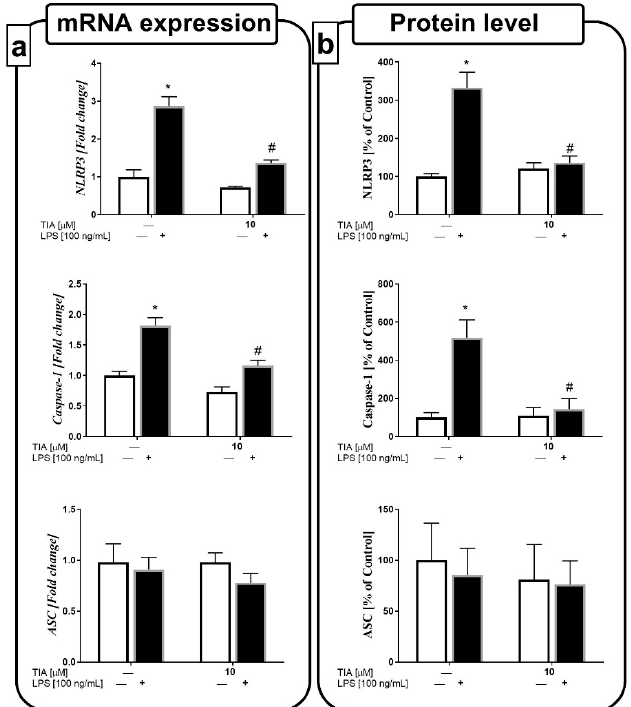
Figure 7. The effect of tianeptine (TIA) on the messenger RNA (mRNA) ( a ) and protein expressions ( b ) of all nucleotide-binding oligomerization domain-like (NOD-like) receptor pyrin-containing 3 inflammasome (NLRP3) subunits, measured in vehicle- and LPS-treated primary microglial cells. Microglial cells were pretreated with tianeptine (TIA; 10 μ M) for 30 min, and then with lipopolysaccharide (LPS; 100 ng/mL) for 24 h. The qRT-PCR data are presented as the average fold ± SEM from independent experiments ( n = 6 in each group). Protein levels obtained from the ELISA test are presented as the mean ± SEM percentage of control (vehicle-treated cells) from independent experiments ( n = 6 in each group). The results were statistically evaluated using two-way analysis of variance (ANOVA) with a Duncan post-hoc test to assess the differences between the treatment groups. Significant differences from the control group (vehicle-treated cells) are indicated by * p < 0.05; differences between LPS-treated groups and pre-treated with tianeptine and then stimulated with LPS groups are indicated by # p <